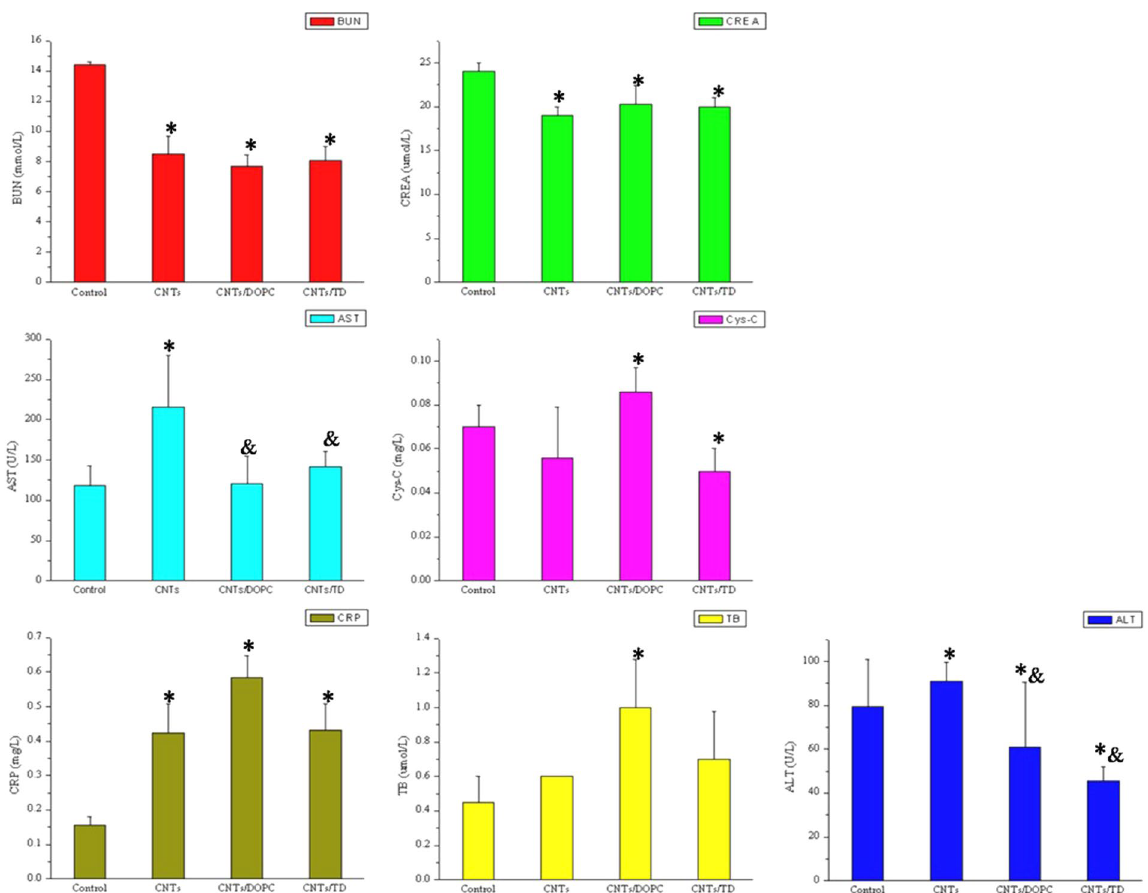
Figure 7. The biochemical indices level of BUN (blood urea nitrogen), CREA (creatinine), AST (aspartate aminotransferase), Cys-C (cystatin C), ALT (alanine aminotransferase), CRP (C-reaction protein) and TB (total bilirubin) change in plasma after exposure oMWCNTs and DOPC/or TD to mice simultaneously ( * p < 0.05 for groups vs . control group; & p < 0.05 for groups vs. single oMWCNTs group; n = 5, +